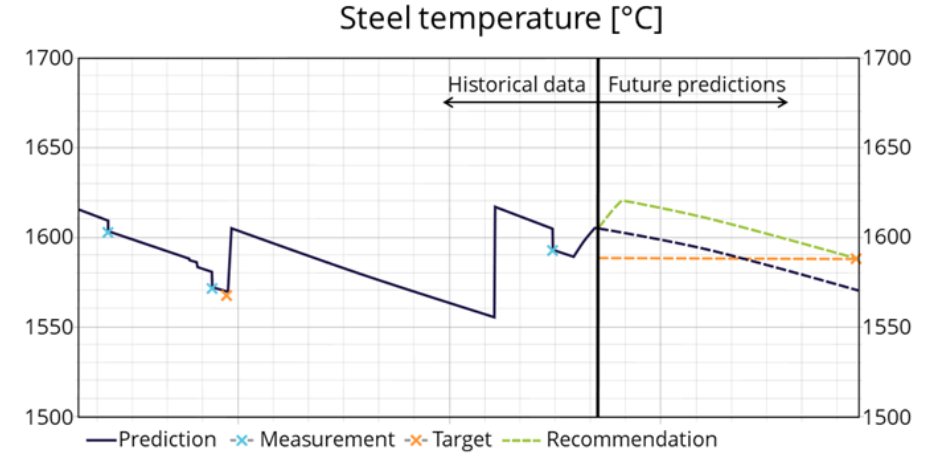
Figure 5. User interface for temperature